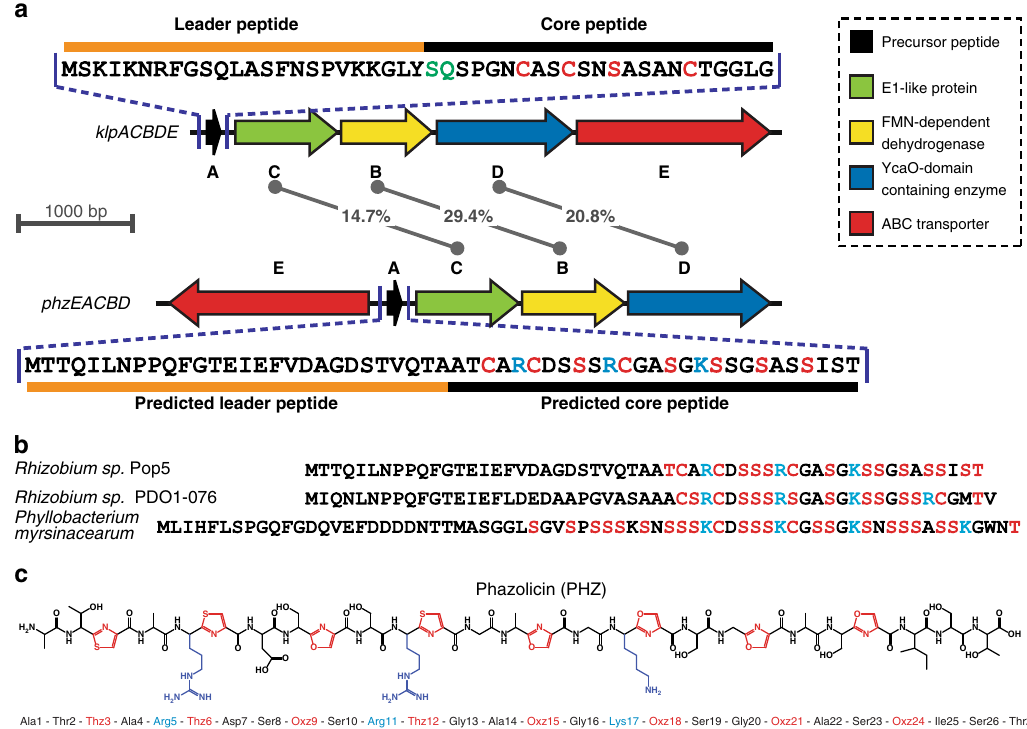
Fig. 1 Organization of the phazolicin (PHZ) biosynthetic gene cluster. a Comparison of klebsazolicin (KLB) biosynthetic gene cluster ( klpACBDE ) with the cluster found in the genome of Rhizobium sp. Pop5. Functions of the genes forming the BGCs are listed on the right. The numbers in the middle indicate the extent of identity between the amino acid sequences of the C, B, and D gene products. The sequence of the KLB precursor peptide is shown above its BGC with the leader and core parts indicated. Residues converted to azoles in the fi nal product are highlighted in red. Residues involved in the formation of the N-terminal amidine cycle are highlighted in green. The sequence of the precursor peptide from the newly identi fi ed BGC is shown below it. Ser and Cys residues in the sequence of PhzA precursor involved in oxazole and thiazole formation, respectively, are shown in red. Positively charged residues of the predicted core part are highlighted in blue. b Alignment of the amino acid sequences of precursor peptides encoded in phzEACBD BGC and BGCs of PHZ homologs from other Rhizobiales ( Rhizobium sp. PDO1-076 and Phyllobacterium myrsinacearum DSM 5893). Ser, Thr, and Cys residues in the predicted core parts of the peptides are shown in red. Positively charged residues are highlighted in blue. c Structure of the fully modi fi ed PHZ peptide after the cleavage of the leader. Cyclized residues are shown in red (Thz and Oxz). Positively charged amino acids are highlighted in